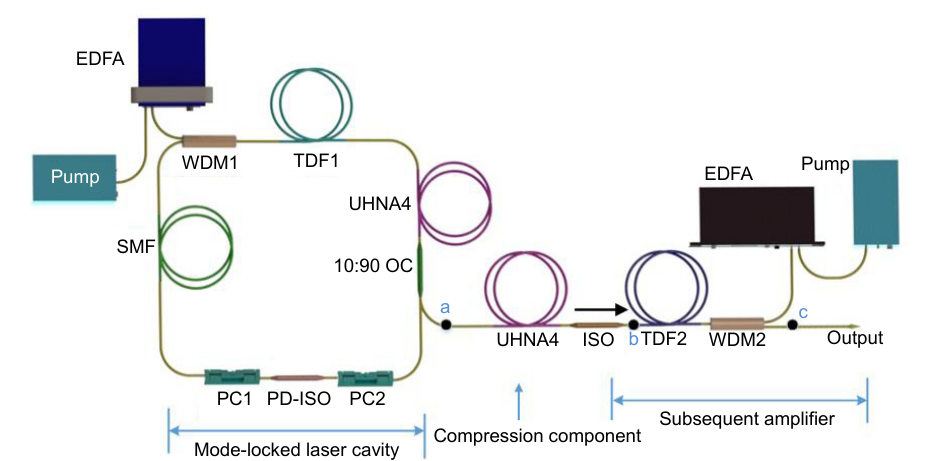
Fig. 1 | Experimental set-up of dispersion-managed mode-locked thulium-doped fiber laser.